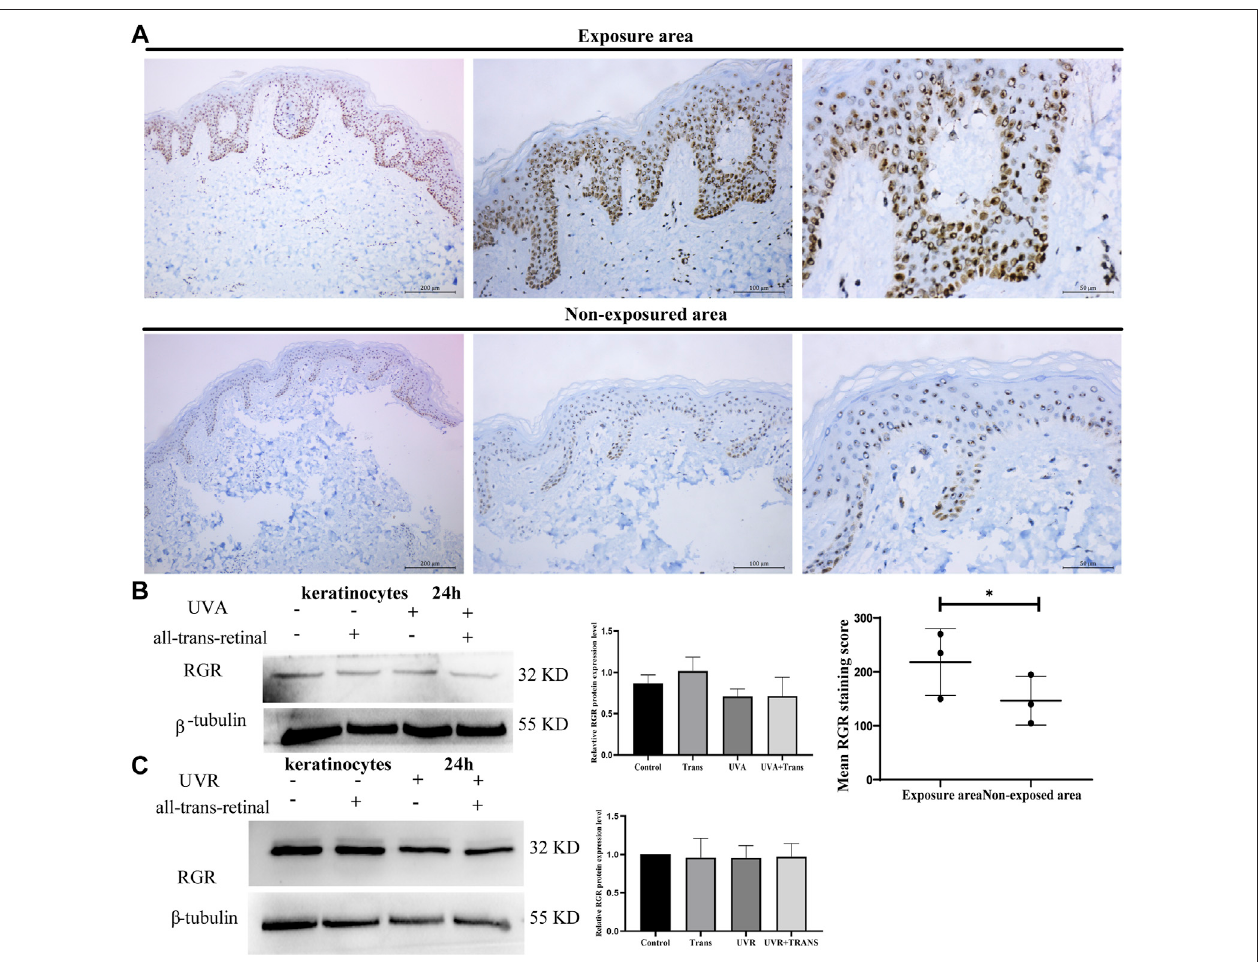
FIGURE3| UVAandUVRmaynotinduceRGRexpressioninhumankeratinocytes. (A) ThedifferentialRGRexpressionintheexposedandunexposedskintissues was analyzed by immunohistochemistry. The RGR was highly expressed in the epithelial layer of light-exposed sites, particularly in the basal cell layer and spinous cell layer of the epidermis and cells of the skin appendages. Exposed area vs unexposed area, * p < 0.05. Scale bar = 100 μ m (right), 50 μ m (middle), 20 μ m (left). (B) Keratinocytes with all-trans-retinal were irradiated with 3 J/cm 2 UVA. Representative expression of RGR and β -tubulin (loading control) by Western blot analysis. The relative protein levels of RGR and β -tubulin were measured using ImageJ software (n = 3 independent experiments). (C) Keratinocytes with all-trans-retinal were irradiated with 1.5 J/cm 2 UVR. Representative expression of RGR and β -tubulin (loading control) was detected by Western blot analysis. The relative protein levels of RGR and β -tubulin were measured using ImageJ software (n = 3 independent